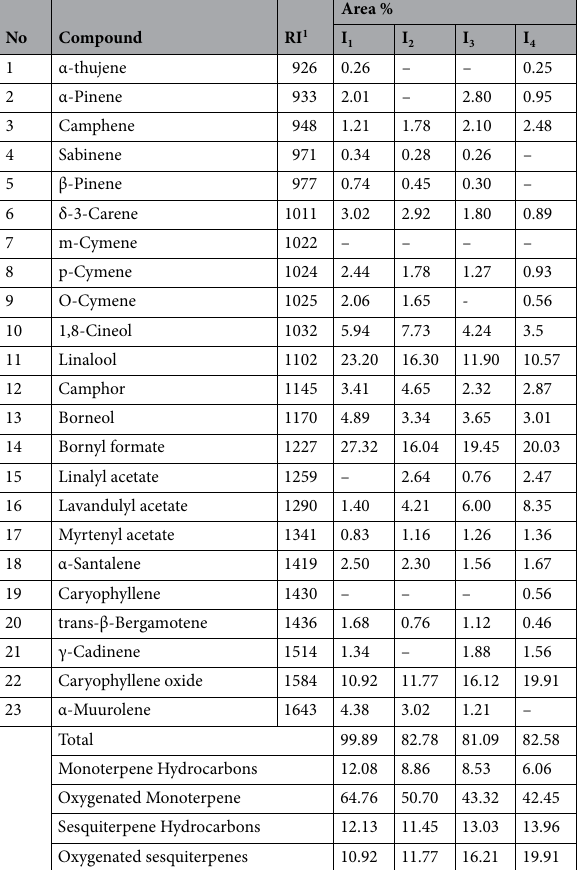
of (5.69%, 10.27%, 11.85% and 15.24%) and 6 oxygen sesquiterpenes with total of (27.89%, 28.09%, 29.44% and 18.32%). With increasing drought, the amounts of hydrocarbon monoterpenes and oxygen sesquiterpenes were decreased; while the amount of hydrocarbon sesquiterpenes was increased. Also the highest amount of oxygen monoterpenes, by 61.03%, was seen in I 2 drought level. Heat map for the essential oil profile in Lavandula stricta corresponding to the different irrigation regime The parallel discrimination was also supported by the heatmap constructed for essential compounds. Accordingly, 18 rows and 4 columns were achieved. α- pinene, Amyl isovalerate, Citronellol, β-Ionone and Linalool from the main compounds, peaked at control. Moreover, α-Thujene, decanal, 1-Decanol, Sesquiphellandrene, Kessane and Hexadecane revealed highest percentage at 30–40% FC (Fig. 13). These results confirm the results obtained from the Lavandula angustifolia cv. Hidcote so that as the water limit increases, the amount of monoterpene compounds decreases and the amount of Sesquiterpene compounds increases. Essential oil yield in M genotype from I 1 to I 4 drought levels was obtained 99.90%, 98.38%, 93.08% and 87.04% (Table 6). As it is shown in Table 6, analysis of the essential oil from M genotype included 27 compounds which its major part was consisted of Camphor (16.82%, 16.32%, 17.11% and 18.30%), Borneol (44.96%, 42.80%, 37.54% and 30.99%) and Caryophyllene oxide (14.68%, 15.21%, 15.90% and 17.21%) from I 1 to I 4 drought levels, respectively. comparison of essential oil components (Table 6) showed that from 27 identified compounds in M genotype, the followings were the most prevalent from I 1 to I 4 levels respectively, including hydrocarbon monoter- pene with total of (17.82%, 17.45%, 13.91% and 9.96%), 12 total oxygen monoterpene compounds with total of (65.95%, 62.05%, 56.96% and 50.42%), 4 hydrocarbon sesquiterpenes with total of (1.58%, 23.23%, 5.42% and 8.09%) and 2 oxygen sesquiterpenes with total of (14.91%, 15.65%, 16.79% and 18.37%). The highest drought level resulted in 31.76% and 17.23% increase in Camphor and Caryophyllene oxide. It also caused 31.07% decrease in Borneol compared to the control (Table 6). Totally, with increasing drought level, monoterpene compounds were decreased and sesquiterpene compounds were increased in lavender genotypes. The major components of essential oil were different in various lavender genotypes in the highest level of drought (I 4 ). In this study in H genotype, the compounds Linalool, Bornyl formate and Caryophyllene oxide;